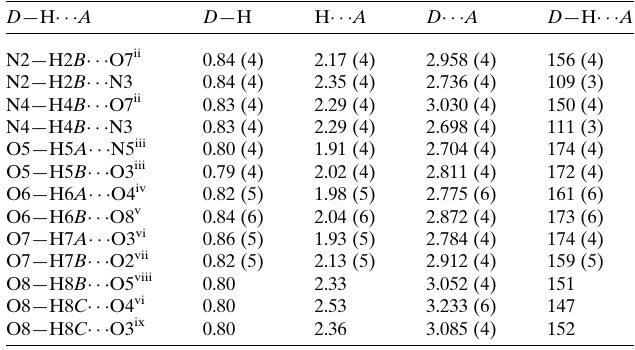
In (I), intermolecular (cid:2) – (cid:2) interactions between the pyridine L 1 ligands play a crucial role in molecular self- rings of the H 2 assembly, with centroid-to-centroid separations of 3.5808 (13) and 3.6269 (14) A˚ . In addition, a number of O—H (cid:2) (cid:2) (cid:2) N and O—H (cid:2) (cid:2) (cid:2) O hydrogen-bonding interactions (Table 3 and Fig. 3) connect separate mononuclear structures to produce a three- dimensional supramolecular framework (Fig. 4). Complex (II) also extends into a three-dimensional supra- molecular network (Figs. 5 and 6) via O—H (cid:2) (cid:2) (cid:2) N and O—